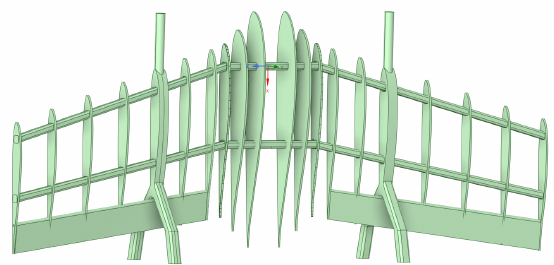
Figure 8. Detailed drawing of the tail-sitter structural